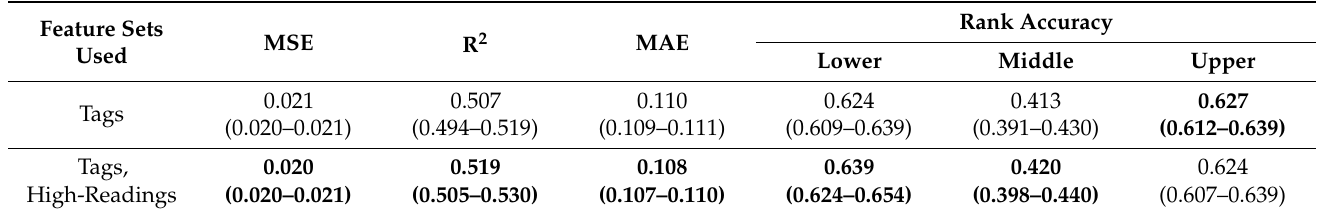
Table 4. Overall performance and rank accuracy of XGBoost models externally validated on RBH cohort. Results are reported alongside 95% confidence intervals (calculated using 1000 bootstrap